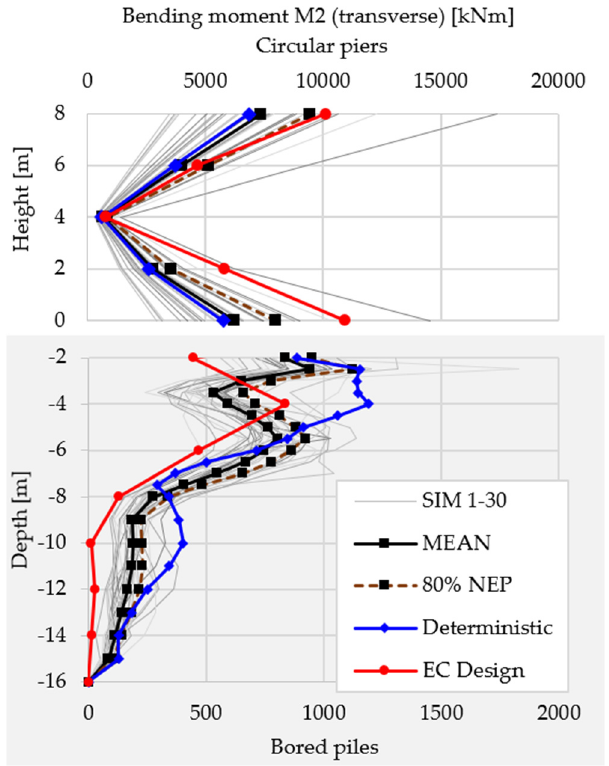
Figure 20. Bending moment M2 (transverse) diagram for pier and bored piles.